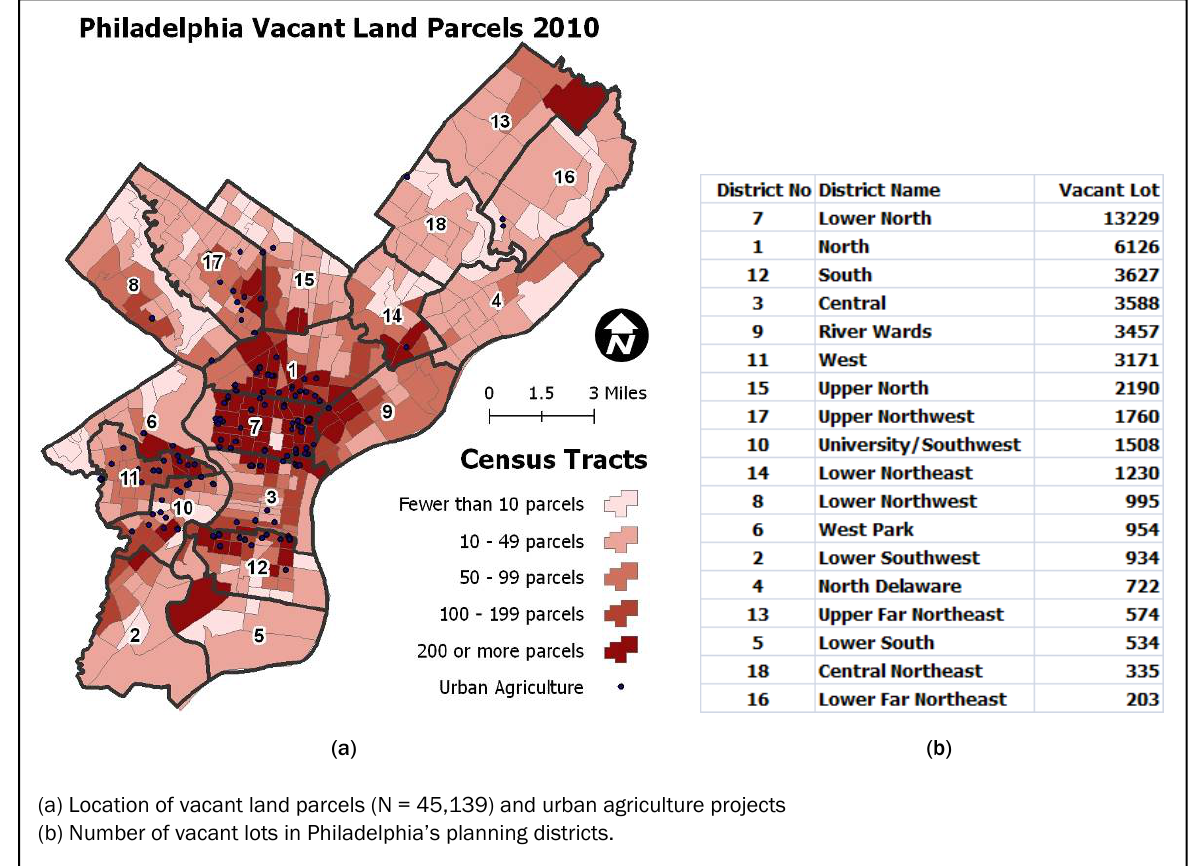
Figure 1. Land Use and Vacant Land Trends in Philadelphia,